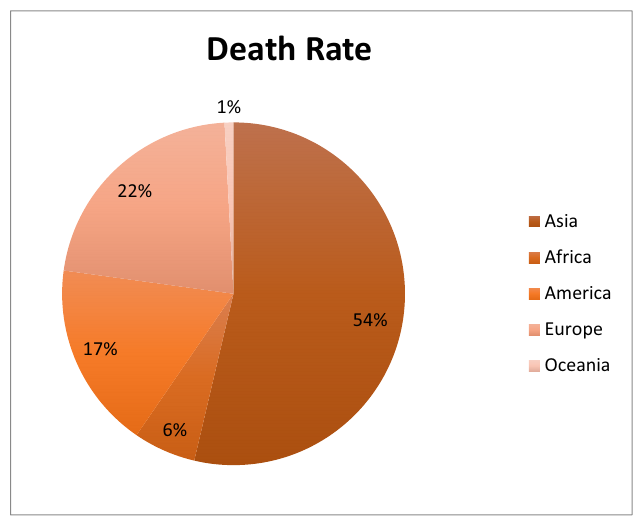
Figure 2: Distribution of brain cancer mortality by